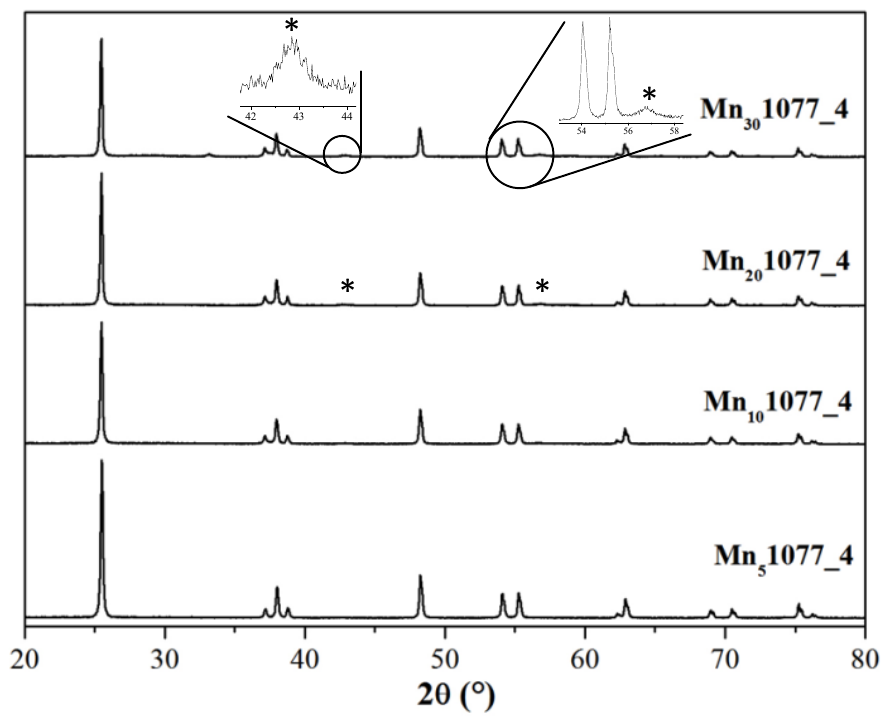
Figure 4. X-ray diffraction lines of Mn x 1077_4 samples (* = MnO 2 pyrolusite